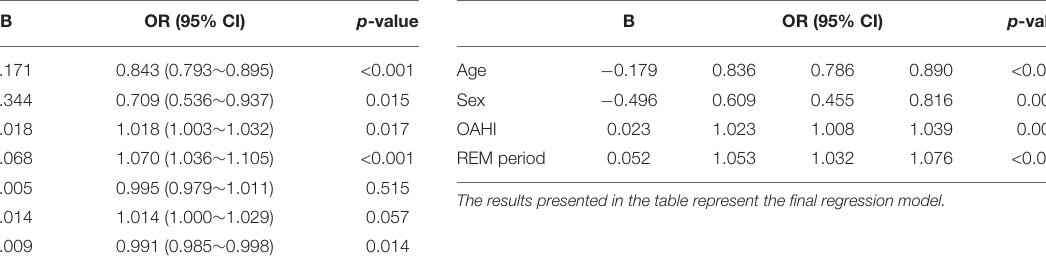
TABLE 4 | Univariate binary logistic regression results: predictors of CA in children with OSA.